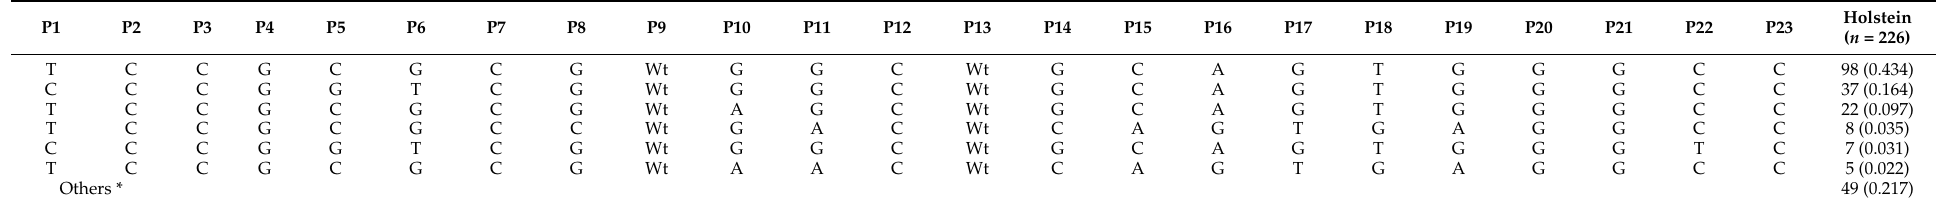
Table 6. Haplotype frequencies of bovine IFITM3 gene polymorphisms in Holstein